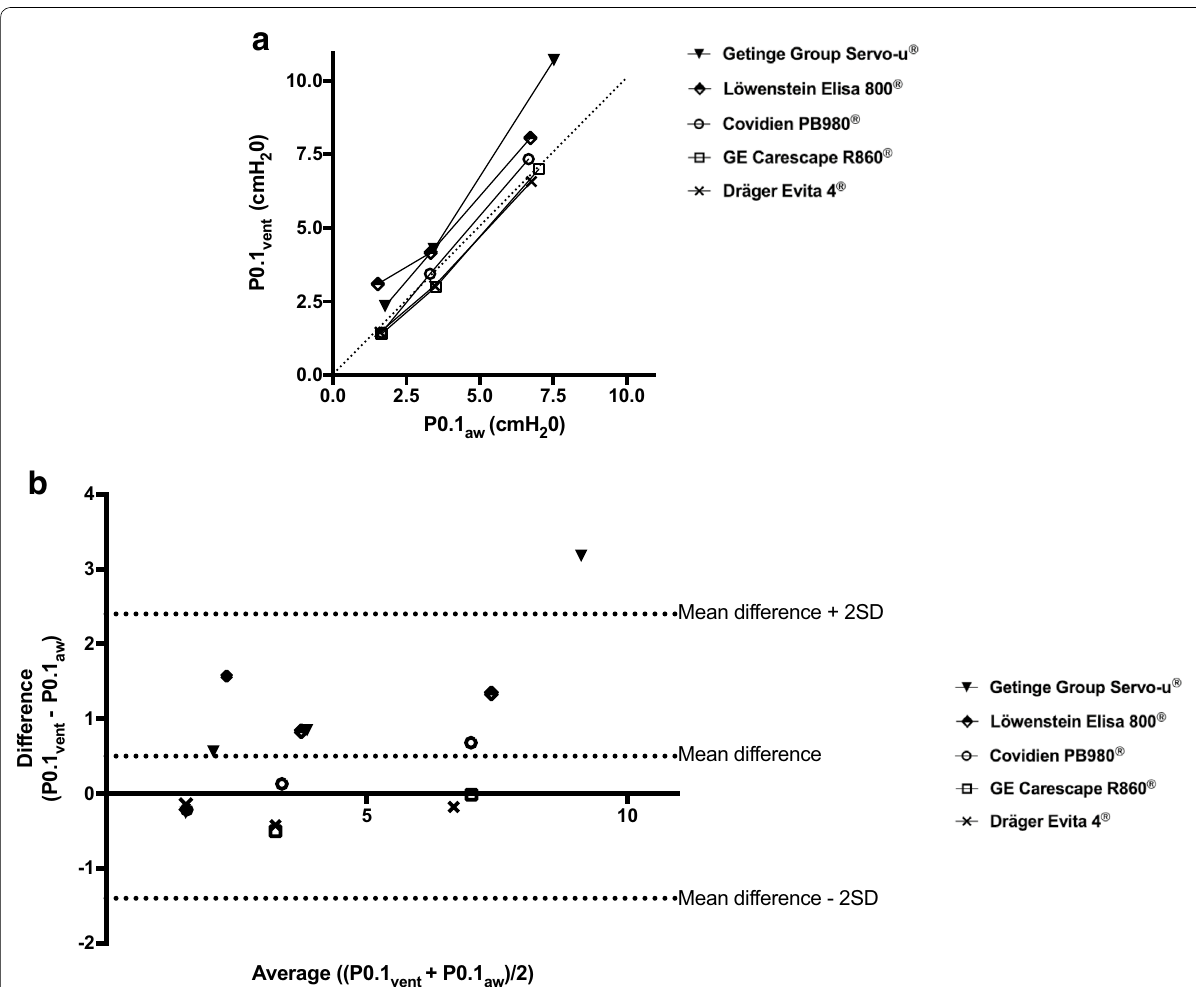
Fig. 3 Relationship between automatically measured P0.1 displayed by the ventilator (P0.1 vent ) and P0.1 measured on the airway pressure during automated P0.1 measurements (P0.1 aw ). a Correlation between P0.1 vent and P0.1 aw . The dotted line represents the identity line ( y Altman plots of differences between P0.1 vent and P0.1 aw versus their mean. The dotted lines represent the mean bias and the limits of